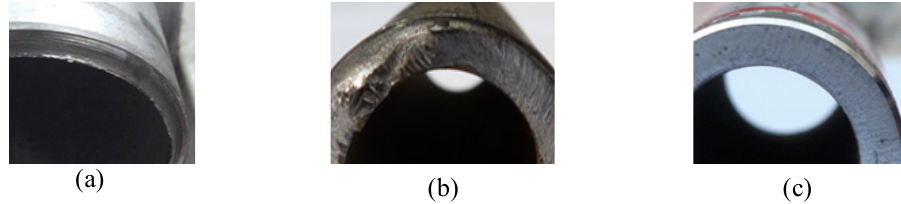
Figure 12. Comparison of tube sections obtained by different separation methods: ( a ) Rotary wedge shear method; ( b ) Impact shear method; ( c ) Fatigue impact loading separation method for a thick- walled tube. Table 4. Comparison of parameters of tube sections obtained by different separation methods. Separation Method Fractional Defect Ratio (%) Section Verticality Section Flatness (mm) Rotary wedge shear method